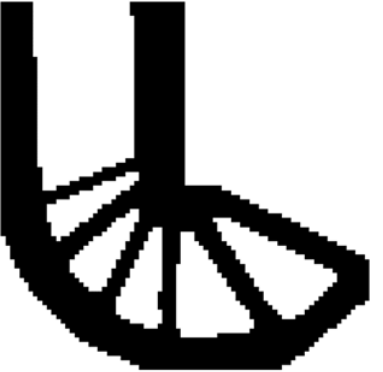
Figure 12. Optimized shape of L-shaped by the improved method.